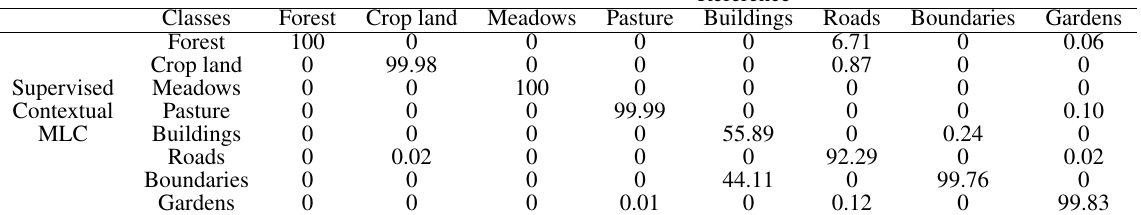
Table 5. Confusion matrix for Supervised Contextual MLC. Values are percentages of the reference test set (column-based normalization), producer accuracy can be read on diagonal values.